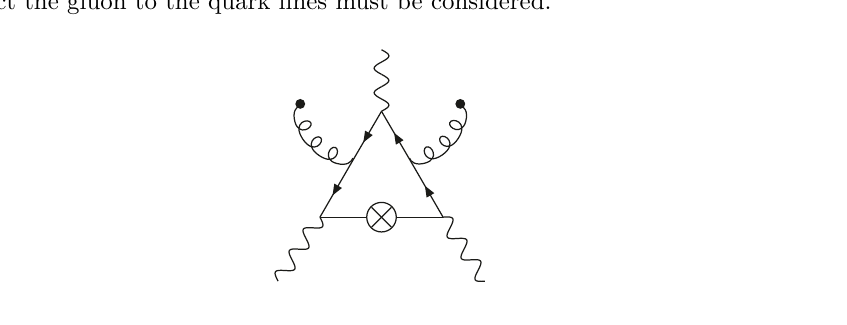
Figure 7 . An example of a topology of the gluon matrix element